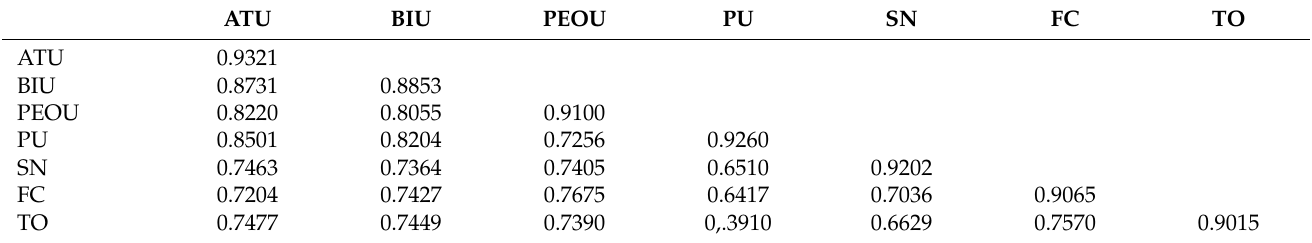
Table 3. Fornell–Larcker